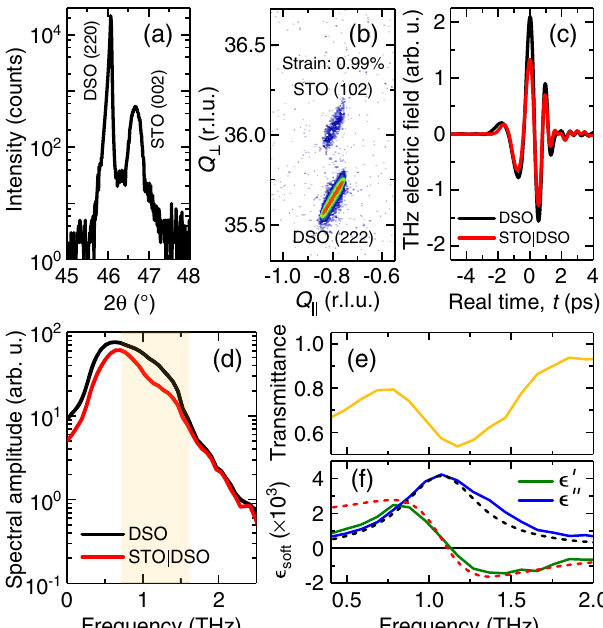
FIG. 2. (a) X-ray diffraction measurement in the θ - 2 θ configu- ration for the 50-nm-thick STO film grown on the DSO substrate. (b) Reciprocal space map around the DSO (222) reflection showing that the STO film is coherently strained, leading to room-temperature ferroelectricity [35]. (c) THz transients trans- mitted through the substrate (black) and the 50-nm film (red) at room temperature. (d) Fourier-transformed spectra corresponding to the THz transients in panel (c). (e) STO film transmittance showing a resonance dip at the soft-mode frequency of 1.17 THz, which is highlighted as the shaded region in panel (d). (f) Real ( ϵ 0 ) and imaginary ( ϵ 00 ) parts of the dielectric function showing, respectively, the zero crossing and a peak at the soft-mode resonance frequency. The dashed lines indicate the fitted dielec- tric function corresponding to a damped harmonic oscillator with a Lorentzian